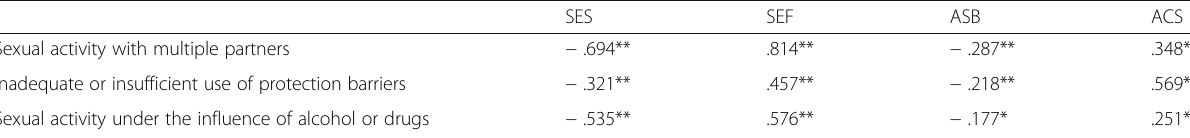
Table 4 Standardised relationships between latent dimensions of the multidimensional scale of sexual self-concept and sexual risk behaviour